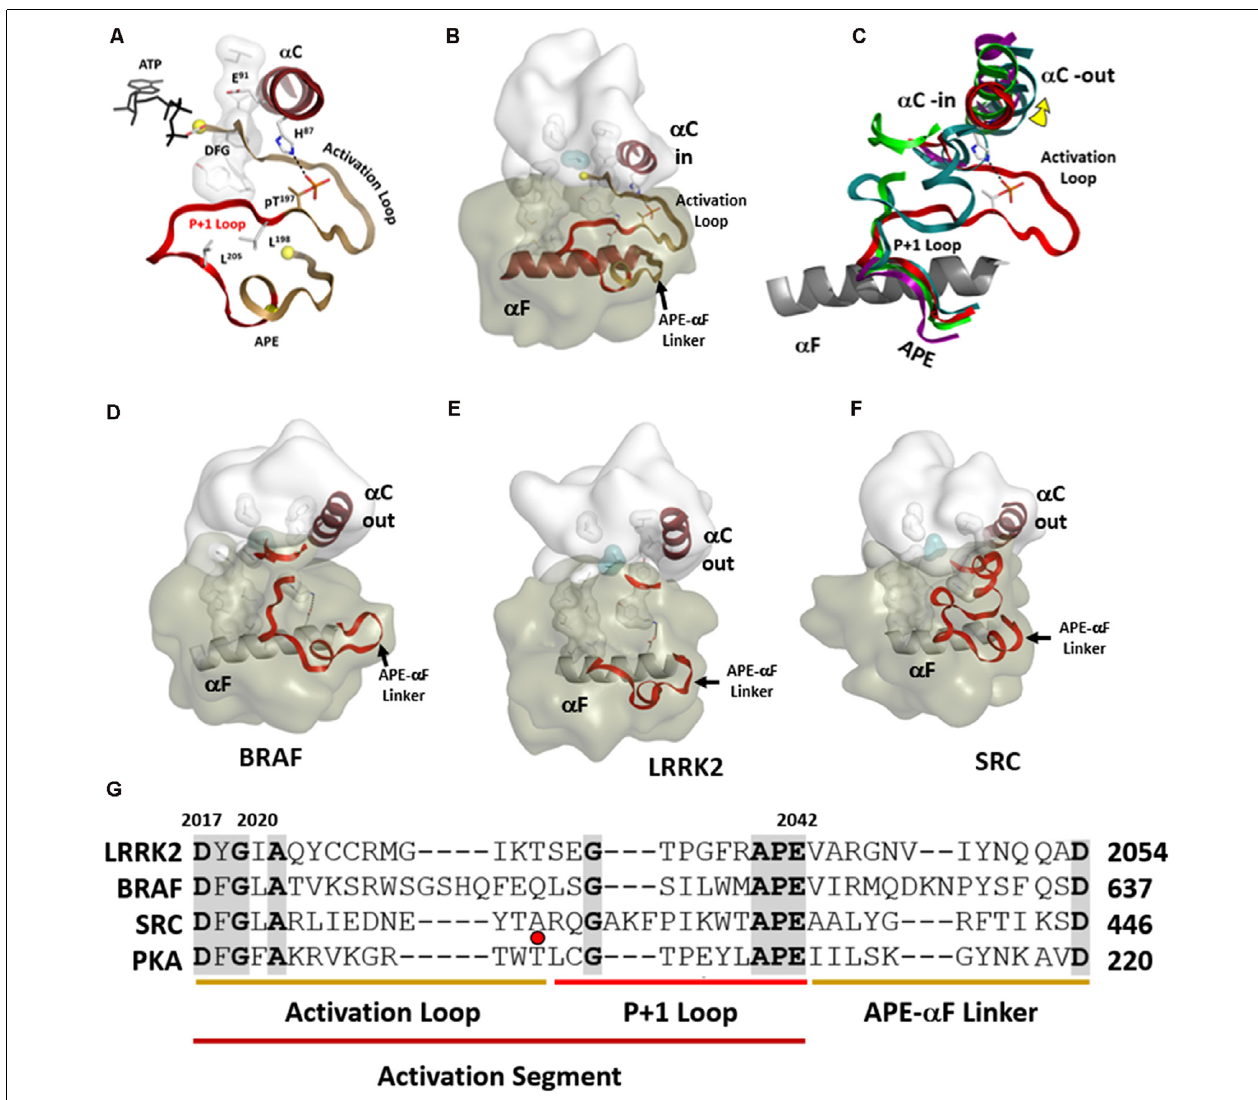
FIGURE 6 | Activation segments. (A) The Activation Loop (tan) and the P+1 Loop (red) in their active conformation, as exemplified by PKA, are shown on the top left. (B) The motif that links the activation segment to the α F-helix (also shown in tan) provides an allosteric docking surface for substrates and other regulatory proteins. These regions are highlighted at the bottom in the sequence alignment of PKA, LRRK2, BRaf, and Src. (C) The three activation segments are aligned and compared to active PKA shown on the right. In each of these inactive structures (D–F) , the α C-helix is in an “out” conformation. The middle panel shows the different ways in which the Activation segment is ordered or disordered in inactive conformations of Src, BRaf, and LRRK2. (G) These regions are highlighted at the bottom in the sequence alignment of PKA, LRRK2, BRaf, and Src. The red dot corresponds to the phosphorylation site in the activation loop of